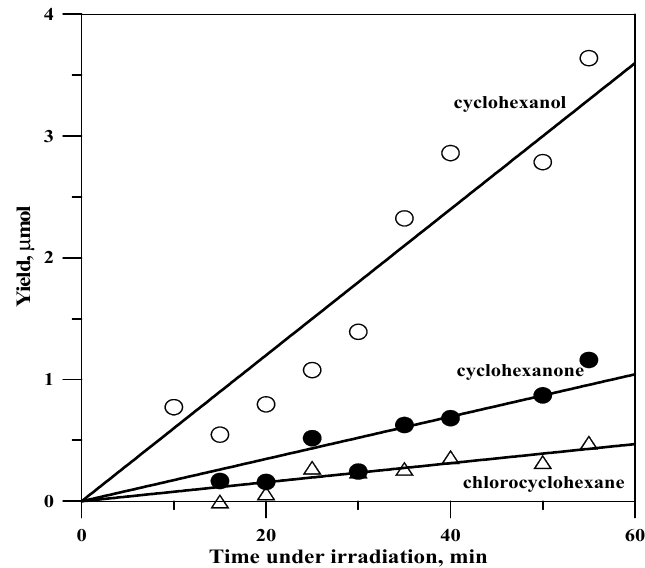
Figure 1. Product development during irradiation (100 W Hg lamp, λ > 360 nm) of 2.0 mL of cyclohexane with 40 mg Et 4 N[FeCl 4 ]. Straight line fits, all R 2 > 0.94.